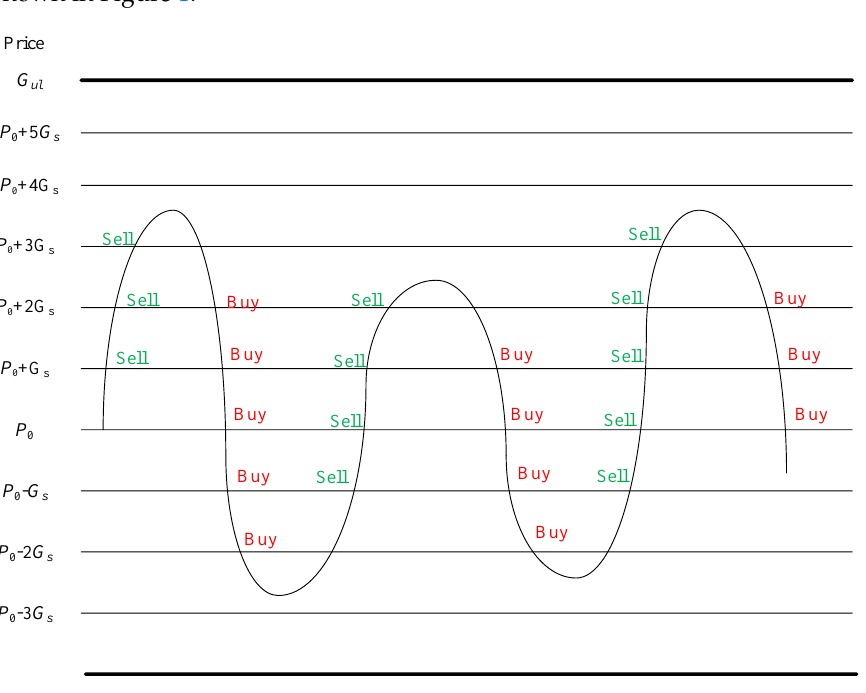
Figure 1. Schematic diagram of equal-distance grid trading.